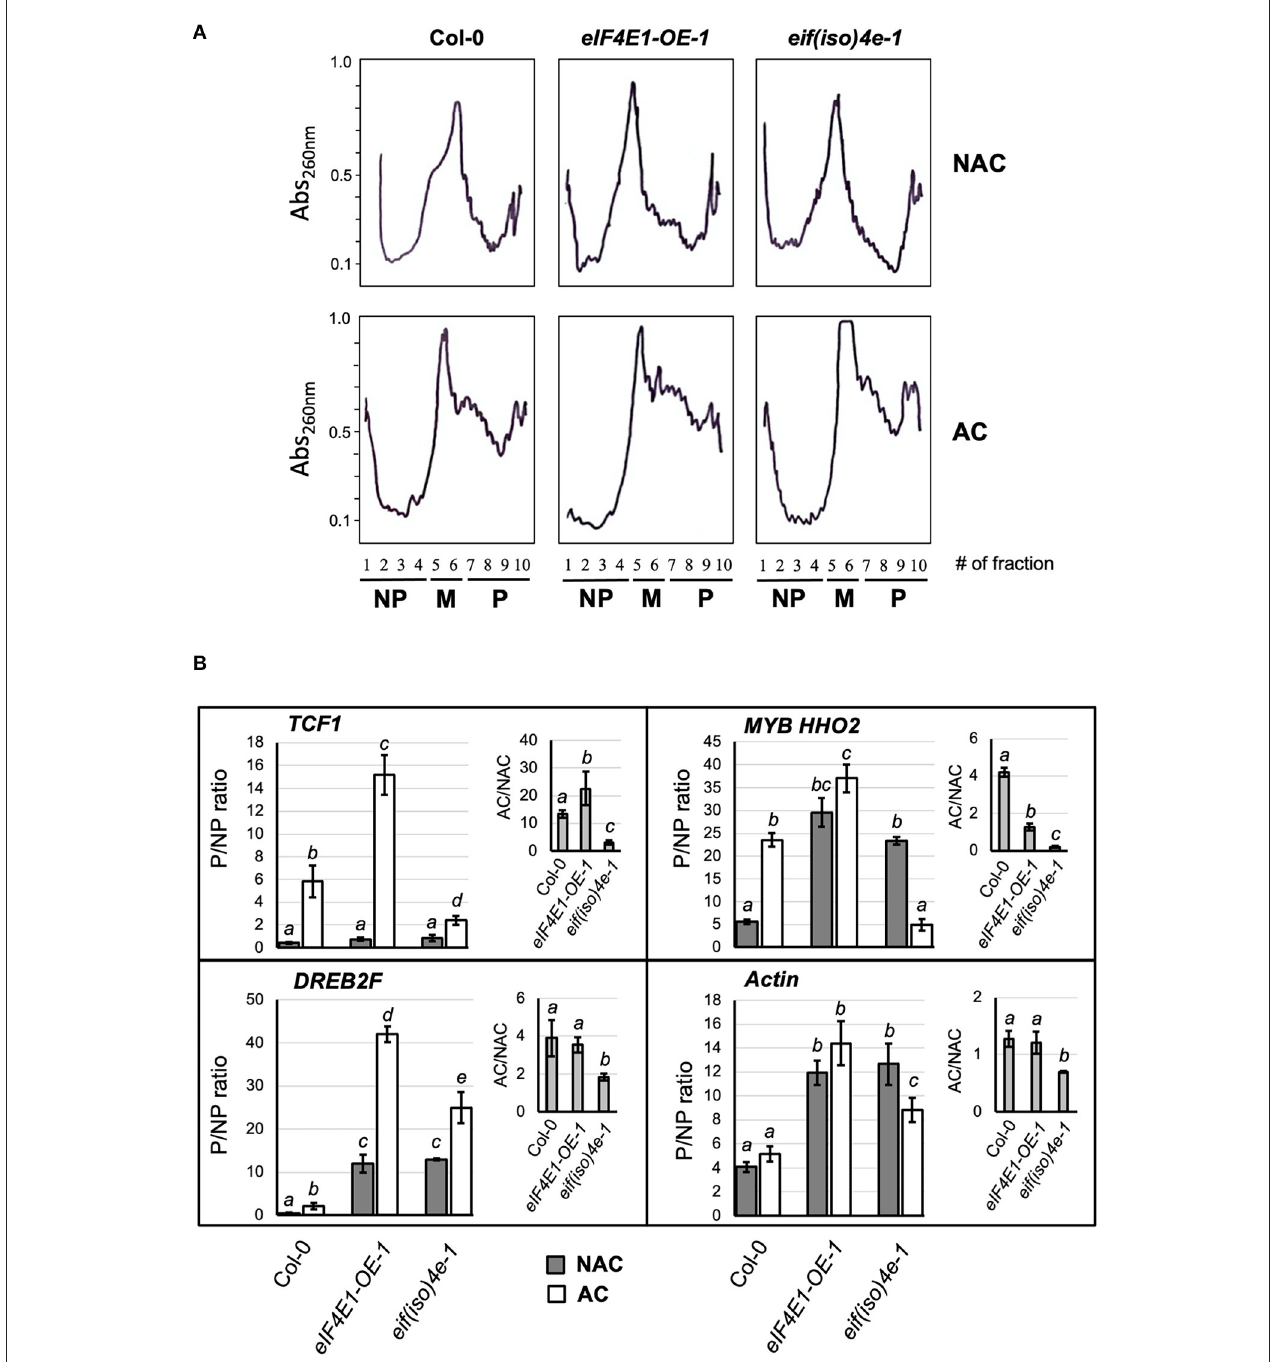
FIGURE 5 | Translation readjustments during plant acclimation to cold temperatures in Col-0 and mutant plants. (A) Sucrose gradient sedimentation profiles. Ribosomal fractions from Arabidopsis thaliana acclimated (AC) and non-acclimated (NAC) 8-week-old adult plants grown under short photoperiod were fractionated on 20 − 60% sucrose gradients and collected in 10 fractions under fixed parameters with continuous monitoring of Absorbance at 260nm (solid line). According to the profiles, fractions 1–4 were considered as non-polysomal (NP), 5–6 as monosomal (M), and 7–10 as polysomal (P). (B) The abundance of mRNAs corresponding to stress-responsive genes was analyzed in NP and P pooled fractions from the sucrose gradient sedimentation profiles shown in (A) . Gray bars refer to non-acclimated plants; white bars refer to plants acclimated for 1 week at 4 ◦ C. Data correspond to RT-qPCR, where P was referenced to NP and normalized by elongation factor eEF-1A for each line and condition (2 − 11 Ct ). Then P/NP ratio was calculated for two independent profiles with three technical replicates and shown as mean values with standard deviation. The AC/NAC ratios for the three lines are represented in the inset graph. Col-0 , wild-type plants; eIF4E1-OE-1 , plants overexpressing eIF4E1; eif(iso)4e-1 , plants knockout for eIF(iso)4E.